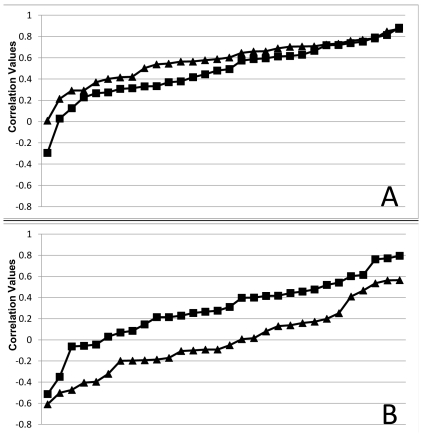
Correlation distributions in LV1 and LV2.Correlation values for all 10-sec blocks, sorted and plotted from lowest (most negative) to highest (most positive), to show the distributions in LV1 and LV2. A) LV1 – Rest1 correlations (squares) are not significantly different from Rest2 correlations (triangles). B) LV2 – Rest1 correlations (squares) are more positive than Rest2 correlations (triangles).